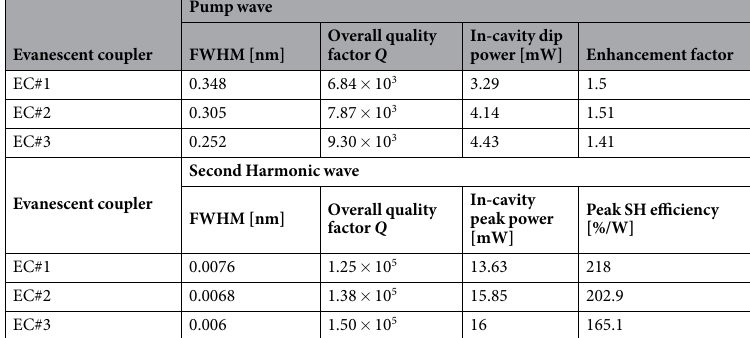
Table 3. Spectral parameters for Pump and SH waves.